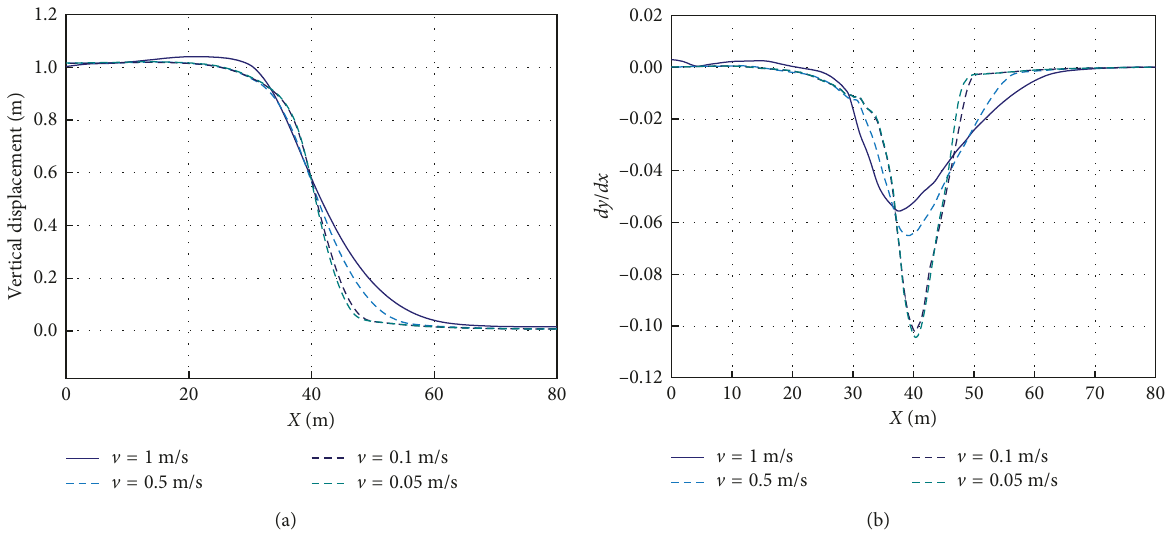
Figure 1: The displacement of the ground surface: (a) vertical displacement and (b) tilt displacement.